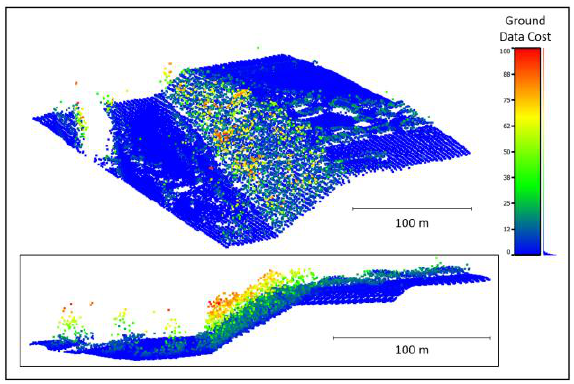
Figure 2. Example of data costs for ground points.